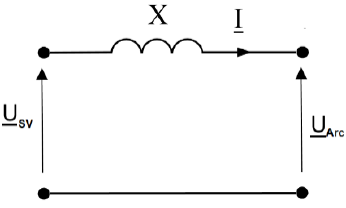
Figure 8. Simplified single-phase equivalent diagram of the arc device, omitting the resistance in the electric arc supply line.